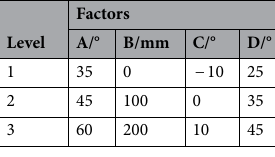
Table 2. Test factor